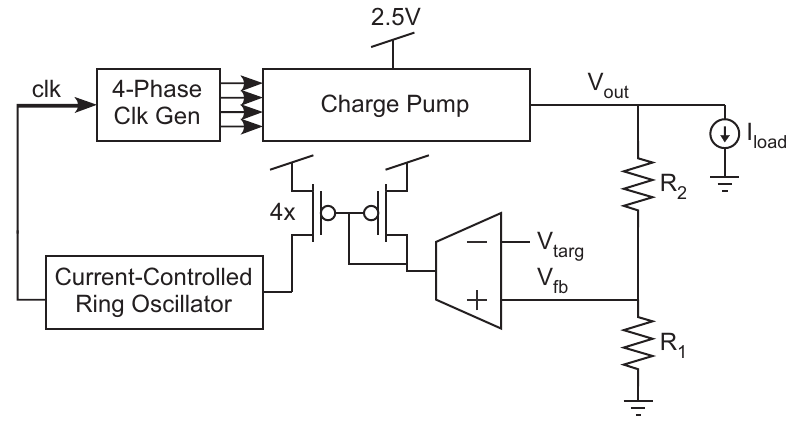
Figure 2. Block diagram of the variable-frequency charge pump we presented in